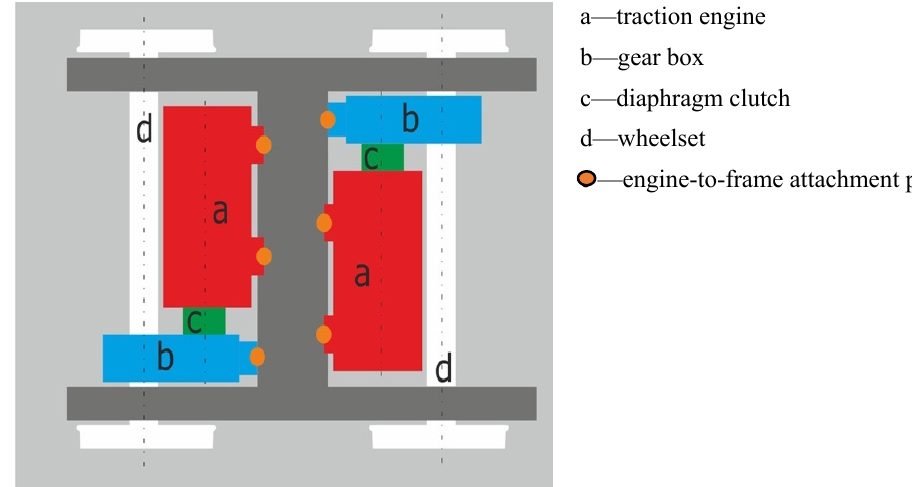
Figure 4. Drive system with two transversely mounted motors, using a diaphragm clutch between the motor and transmission, source: www.transportszynowy.pl, (accessed on 20 June 2022), website owner: Maciej Górowski.